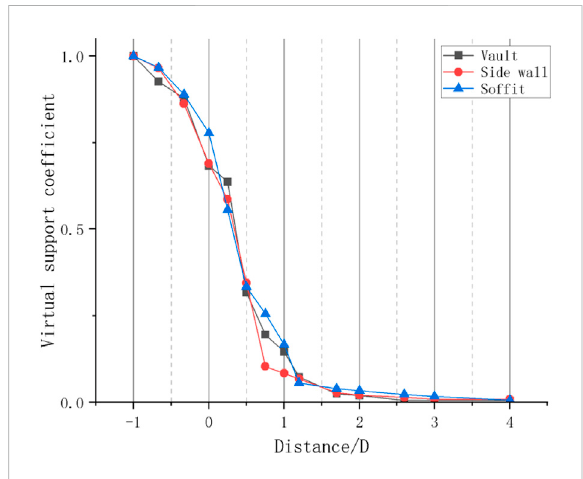
FIGURE 1 Virtual support force distribution in tunnel